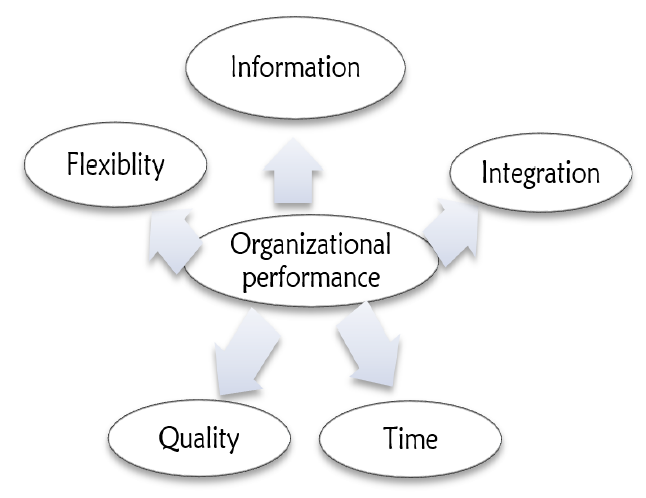
Figure 1: Conceptual